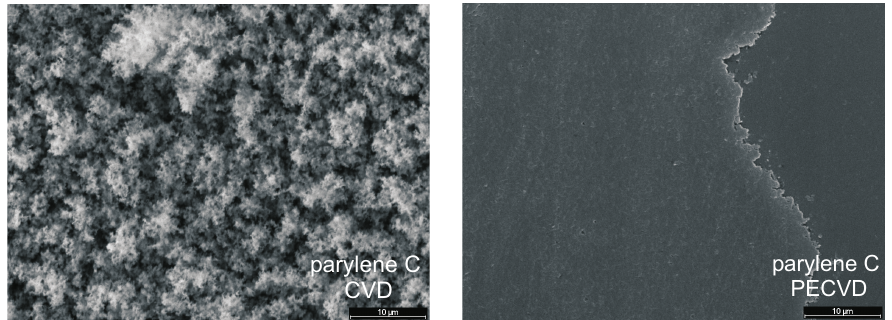
Figure 35. SEM of parylene C, copolymerized with CF 4 : CVD generates rough a surface in a microscopic scale (LHS, scaling bar is 10 µ m). Microscopic dust particles in the ambient were incorporated during the coating process resulting in an opaque layer (volume polymerization). PECVD layers remain their transparency and exhibit a super-fluidic performance (RHS, scaling bar is 10 µ